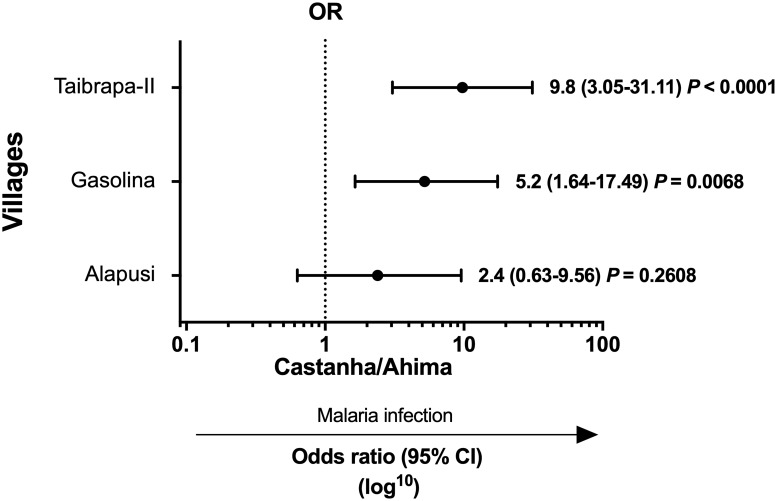
Odds ratios (ORs) for the relative risk of malaria infection in each village compared with Castanha/Ahima (the village with the lowest number of malaria infections, used as the reference).At first baseline survey, the inhabitants of Taibrapa were temporarily located in their alternative residence (Taibrapa-II). Crude OR were obtained by using 2x2 contingency tables with a 95% confidence interval (CI). P < 0.05 was considered significant. Malaria infection was confirmed by either conventional light microscopy (microscopically-confirmed cases) or species-specific PCR-based assays (submicroscopic or low-density infections).